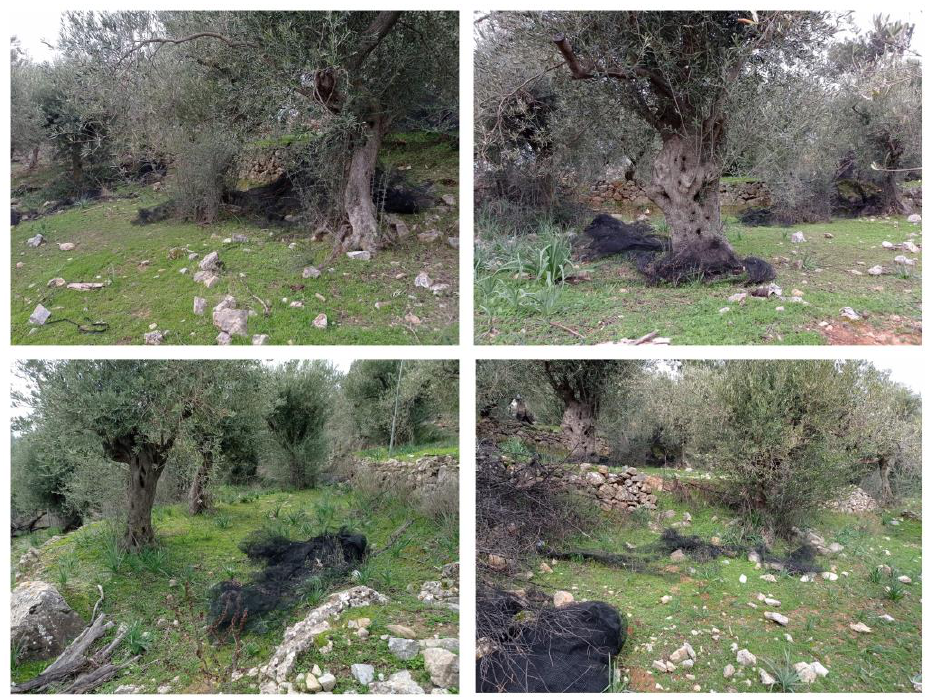
Figure 2. Dispersed olive nets in different locations within a traditional olive grove on the island of Lesvos. The dearth of management is apparent both from the presence of the abandoned olive nets and from the unpruned olive trees.